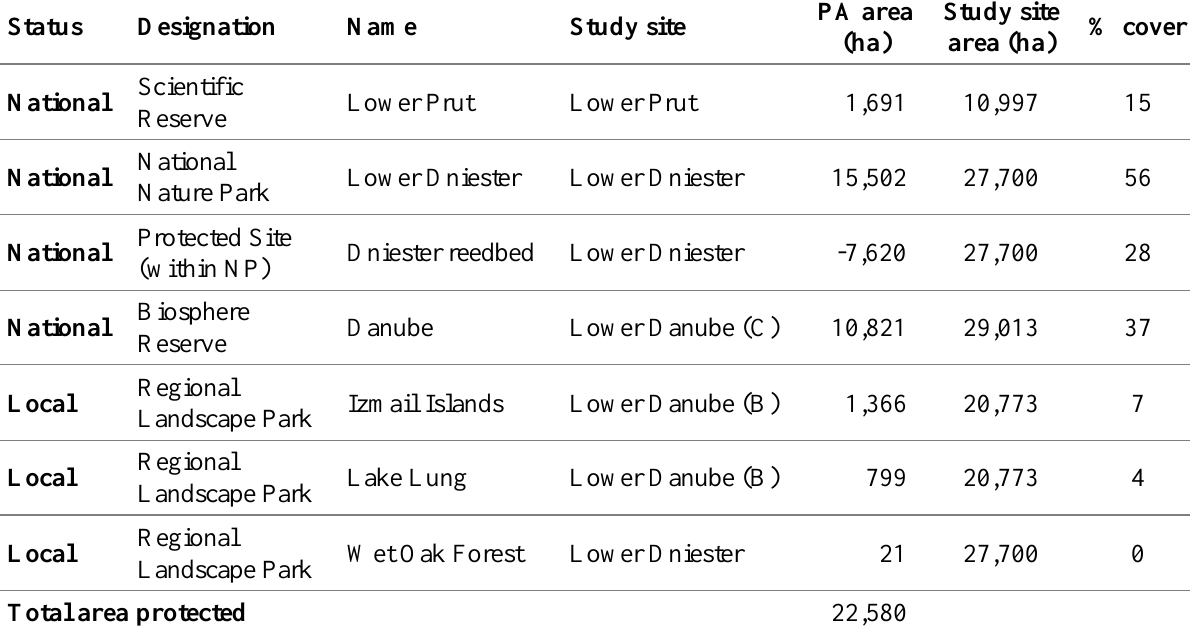
Table 4. Protected areas in the ReedBASE study sites (figures in ha, rounded). Source: ReedBASE